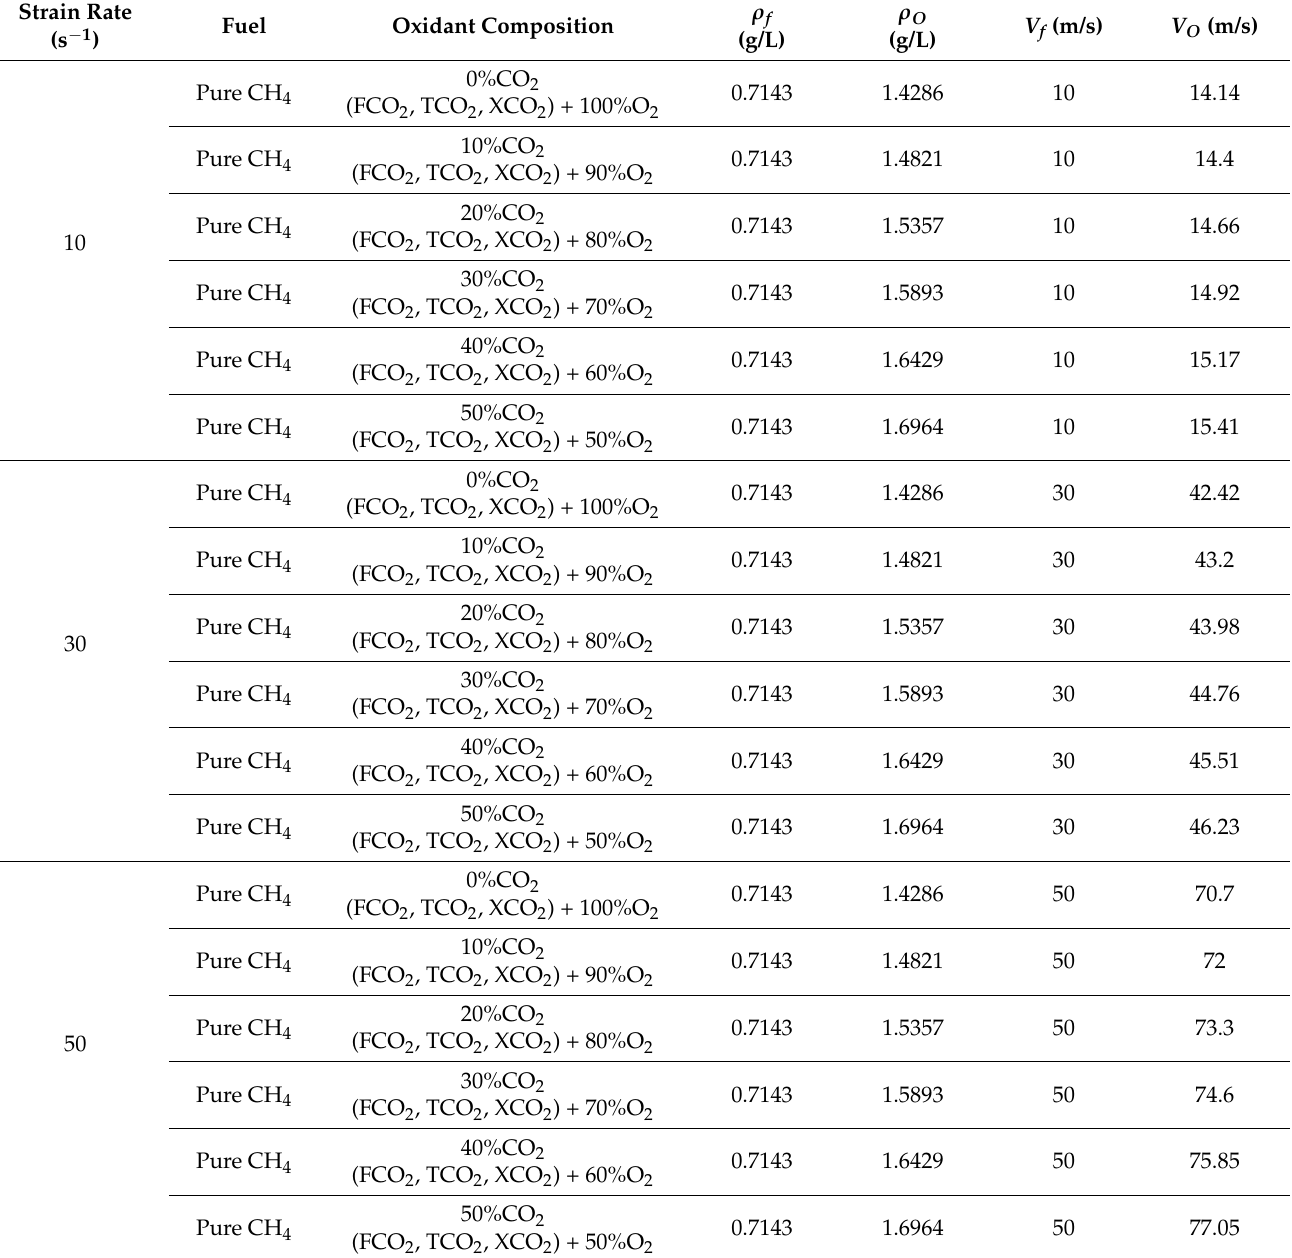
Table A1. The boundary conditions of the fuel side and the oxidizer